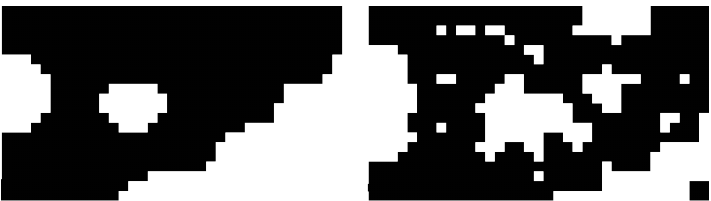
Figure 9. Solutions to the design problem given in Figure 7 obtained with genotype-phenotype mapping enabled ( left ) and disabled ( right ). Both solutions were chosen after 120 generations with a population size of 300 at a relative mass of r = 0.7.